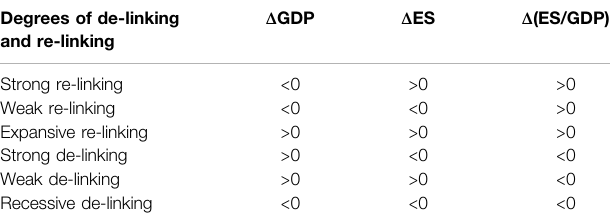
TABLE 1 | Degrees of de-linking and re-linking environmental stress